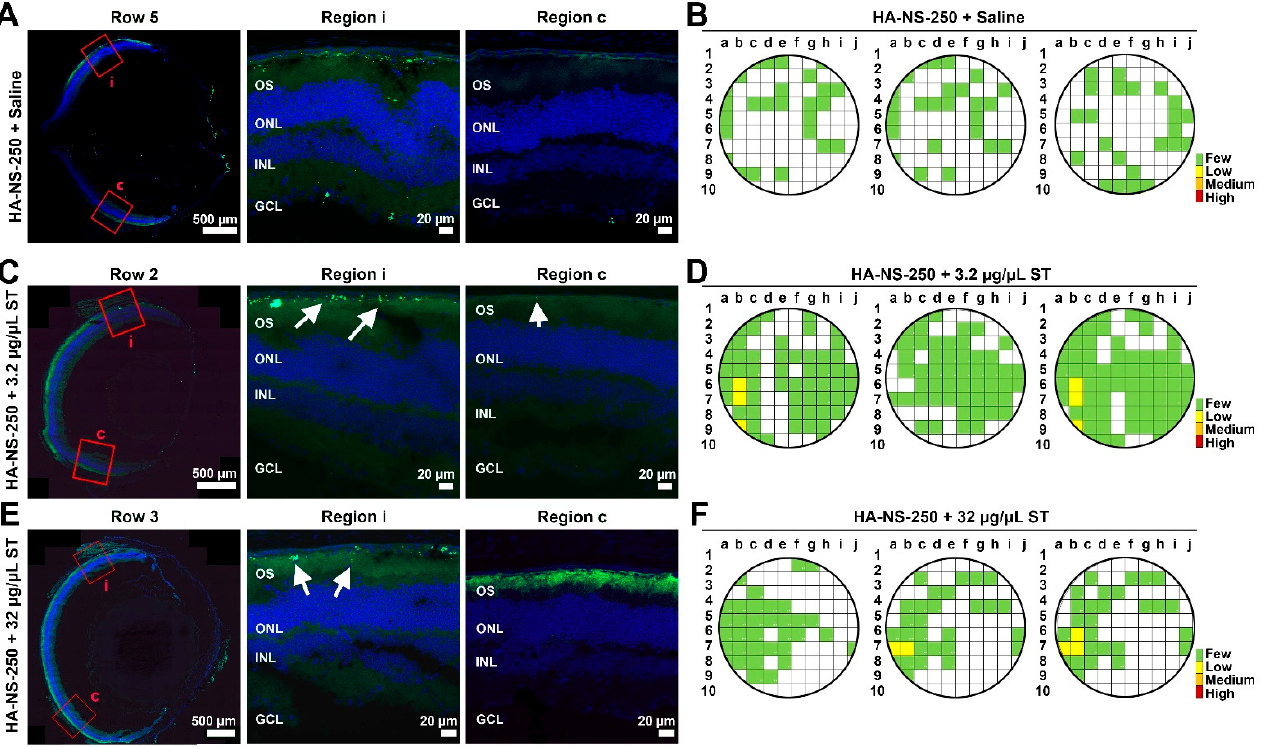
Figure 8. Co-injection of ST with HA-NS-250 leads to improved nanospheres uptake into the retina at PI-14 days. Adult mouse eyes were co-injected with 1.5 µL (5.8 × 10 6 particles/µL) HA-NS-250 and either 1.5 µL saline (vehicle, A , B ) or ST with a final concentration of 3.2 µg/µL ST ( C , D ), or 32 µg/µL ST ( E , F ). Tissues were collected at PI-14 days and sectioned as in Figure 2A,C,E. Shown are representative retinal cross sections (left) with red boxed regions shown on the middle and right. White arrows highlight accumulation of HA-NS-250 in the retina. ( B , D , F ) HA-NS-250 were counted in adjacent regions throughout a retinal section and in multiple sections throughout the eye. Each row corresponds to a section, and each box corresponds to a region in that section. Shown are maps from three different eyes. White squares contained fewer than 10, green squares contained 10–199, yellow squares contained 200–499, orange squares 500–999, and red squares ≥ 1000 HA-NS-250 puncta. OS: outer segments, ONL: outer nuclear layer, INL: inner nuclear layer, and GCL: ganglion cell layer. Scale bars: 500 µm and 20 µm. n = 3 eyes per group.